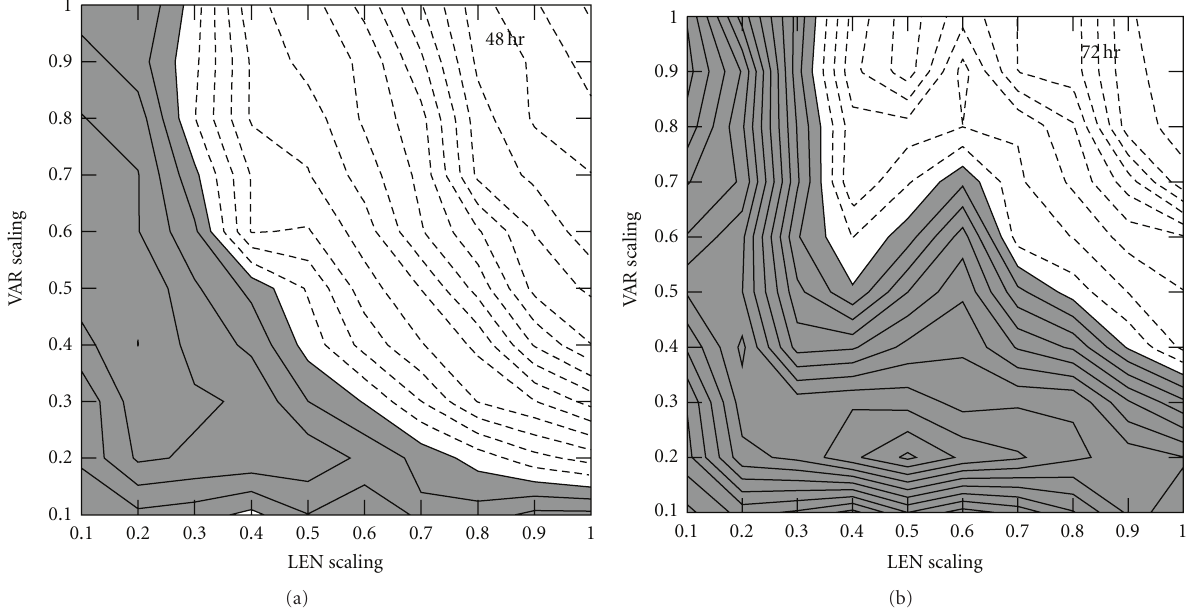
Figure 4: The contour plots for the “forecast error of the control run” minus “forecast error of an individual forecast with AIRS data” under a given pair of values of LEN SCALING (abscissa) and VAR SCALING (ordinate). The forecast error is for the typhoon track measured by the distance between the predicted and observed (best track) locations of the center of the typhoon. A positive value in the plot indicates that the forecast with AIRS data produces a smaller error compared to the control run (that does not incorporate AIRS data). Contour interval is 25km. Positive values are shaded in gray.